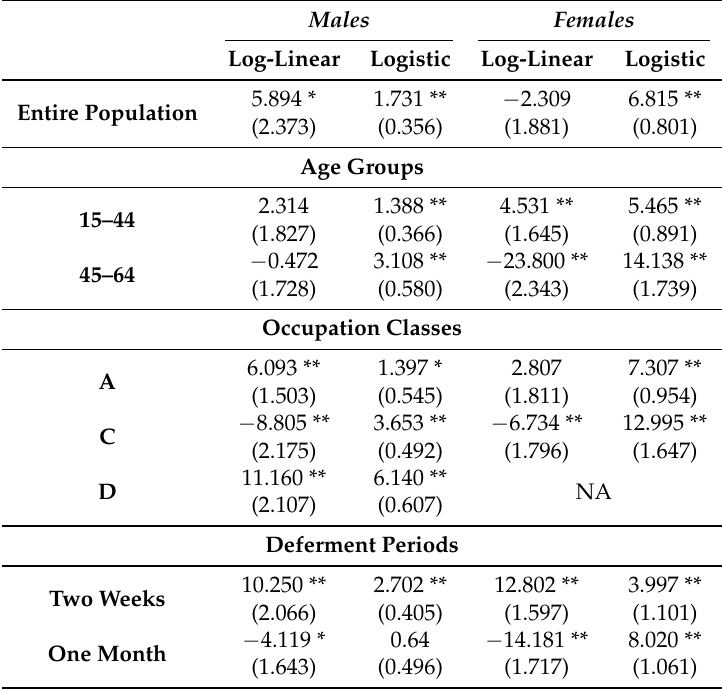
Table 4. Coefficient estimates for unemployment rate in the hurdle